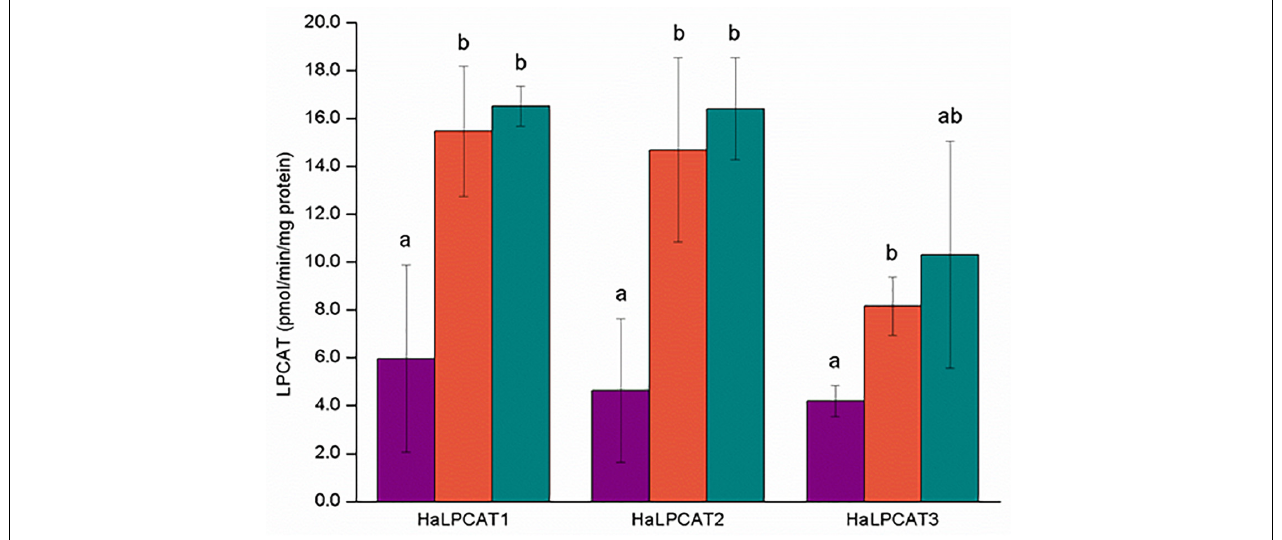
FIGURE 7 | Phosphatidylcholine species specificity of the reverse reaction catalyzed by microsomal recombinant Ha LPCATs. The substrates used were sn -1,2-dioleoyl-phosphatidylcholine (purple), sn -1-oleoyl- sn -2-linoleoyl-phosphatidylcholine (orange), and sn -1-oleoyl- sn -2-linolenoyl-phosphatidylcholine (green). Data are the mean of three replicates with ± standard deviation. The letters indicated the groups of statistical significance according to a one-way ANOVA with Tuckey post hoc analysis at a significance level of